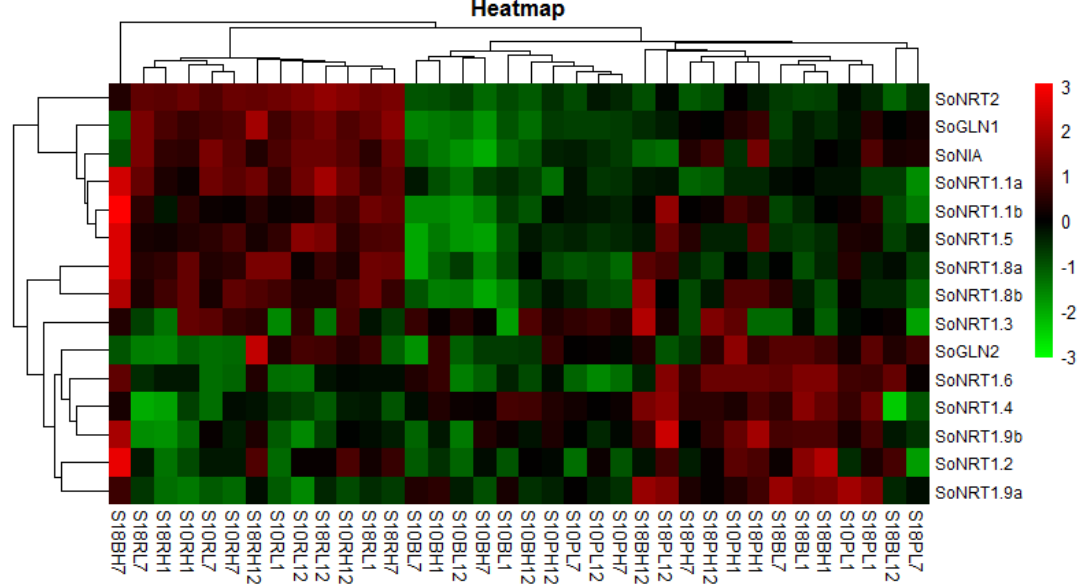
Figure 5. Expression profiles of NRTs genes in tissues of two spinach varieties under two nitrate concentration treatments. S10, the spinach So10 variety; S18, the spinach So18 variety; B, leaf blade; P, petiole; R, root; L, low nitrate (0.5 mmol·L −1 ) treatment; H, high nitrate (15 mmol·L −1 ) treatment; 1, 1 h; 7, 7 h; and 12, 12 h.